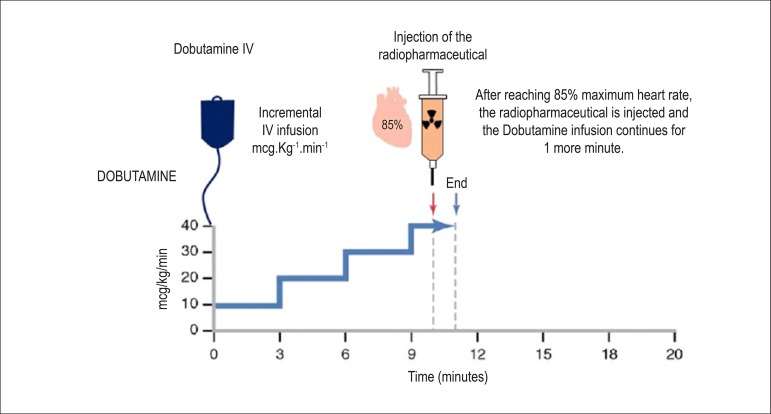
Myocardial perfusion scintigraphy associated with intravenous administration of dobutamine solution (250 mg or 1 vial diluted in 250 ml of saline solution). It may begin with an alternative initial dose of 5 mcg.kg-1.min-1, for 3 minutes, with sequentially increasing doses every 3 minutes, up to 40 mcg.kg-1.min-1 or until 85% of maximum heart rate has been reached (explained in the figure and the text), at which point the radiopharmaceutical (MIBI-99mTc or 99mTc-tetrofosmin) is injected. In the event of inadequate increase in heart rate and in the absence of contraindications (glaucoma, prostatic hypertrophy), atropine is additionally recommended, either early on or starting at the third step.